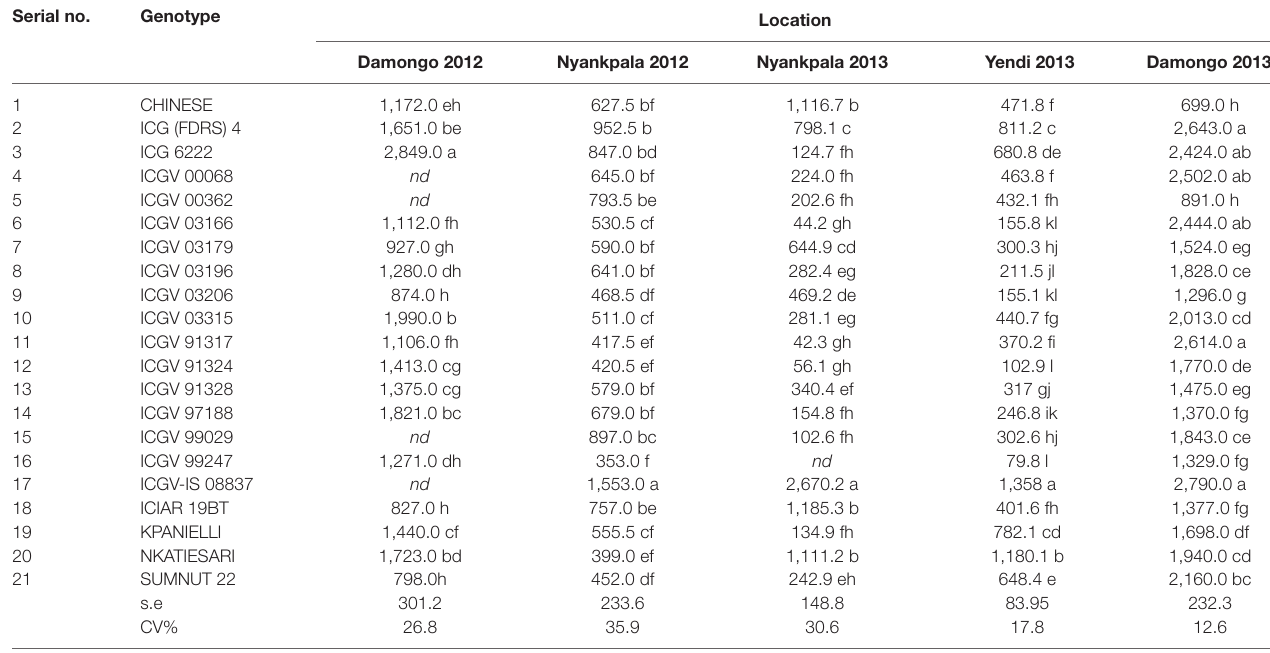
TABLE 3 | Mean pod yield (kg ha −1 ) of groundnut genotypes evaluated in the guinea savanna of Ghana between 2012 and 2013. Serial